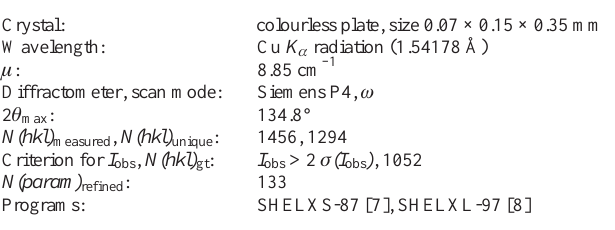
Table 1. Data collection and handling.